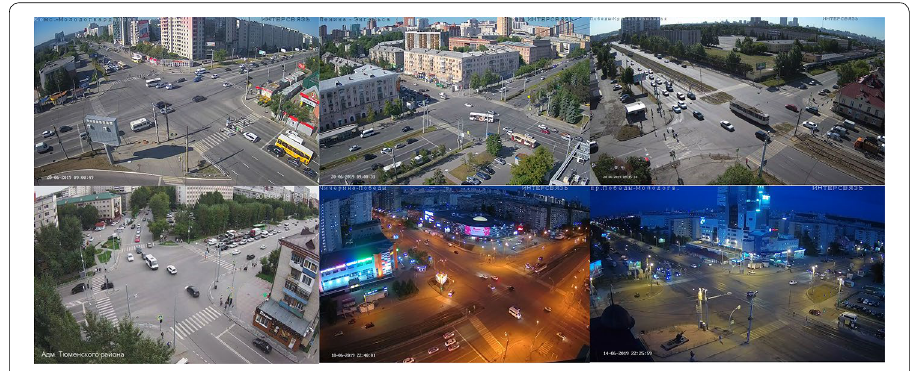
Fig. 3 Examples of an input image